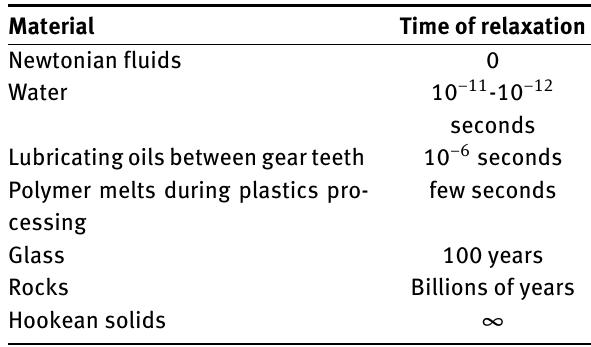
Table 2: Time of relaxation of some